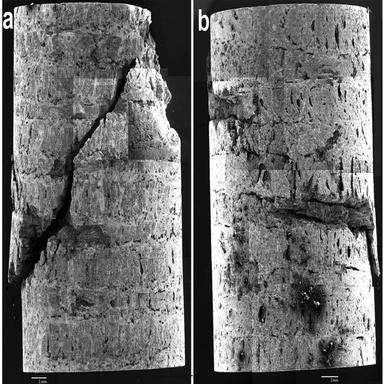
Low magnification SEM images of the bottom surface of the Cf-HfB2 powder composites after compressive testing across the plies. (a) Strongest sample (b) weakest sample.